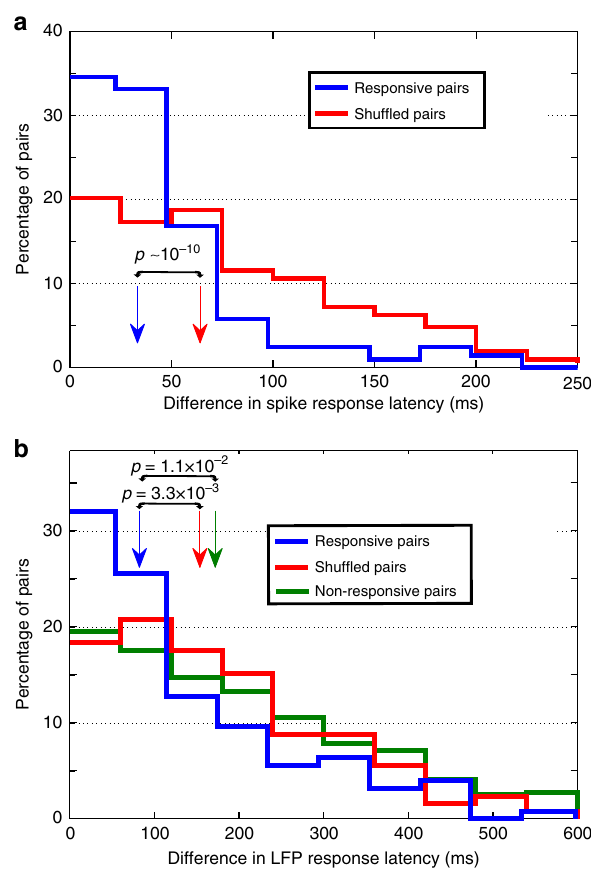
Fig. 4 Multi-responsive units do not exhibit differences in spike or LFP response latencies. a Distribution of spike latency difference for the response-eliciting pairs and for a representative case of randomly chosen pairs. The arrows mark the median of the distributions, which were signi fi cantly different ( n = 208, one-sided rank-sum test, p ~ 10 − 10 ). b Same as a but for the LFP response latency difference. The response-eliciting pairs showed signi fi cantly less difference in LFP latency than the one obtained on a representative distribution of shuf fl ed pairs ( n = 125, one- sided rank-sum test, p = 3.3 × 10 − 3 ). In addition, the distribution of latency differences for the response-eliciting pairs was signi fi cantly smaller than for non-response-eliciting pairs ( n = 6839 for non-response-eliciting pairs, one-sided rank-sum test, p =